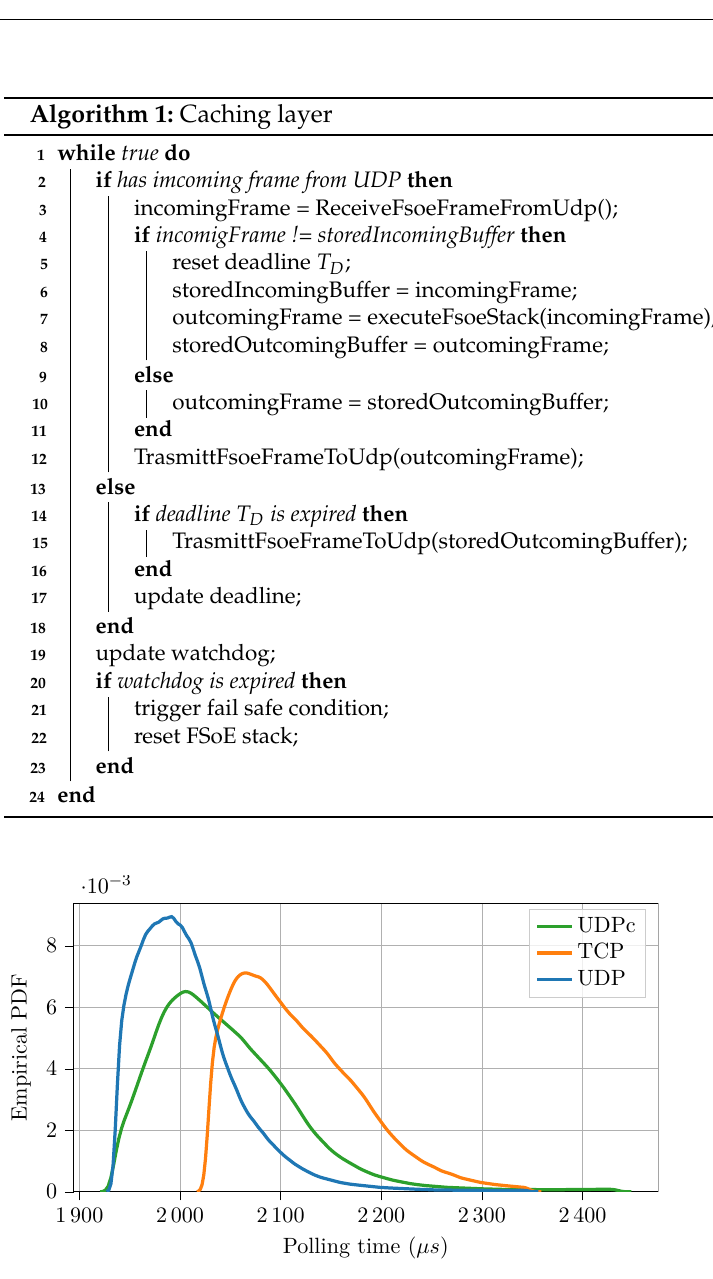
Figure 6. EPDF of the polling time for different transport layers on